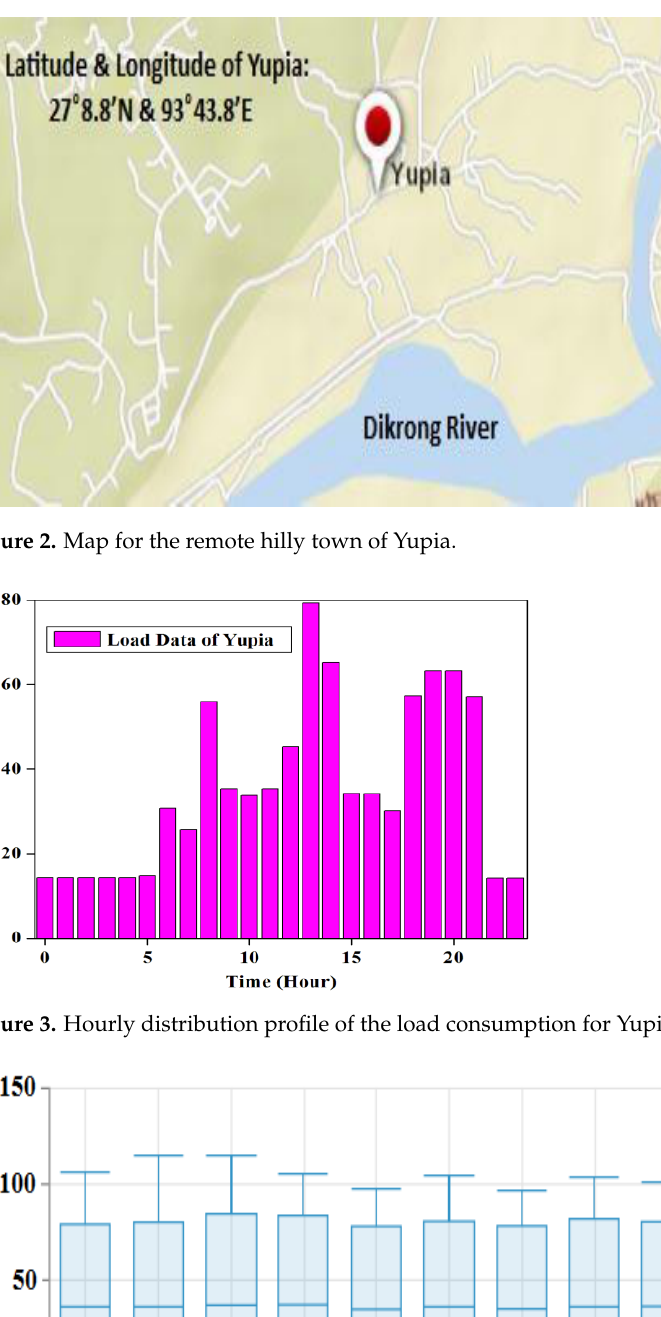
Figure 2. Map for the remote hilly town of Yupia.